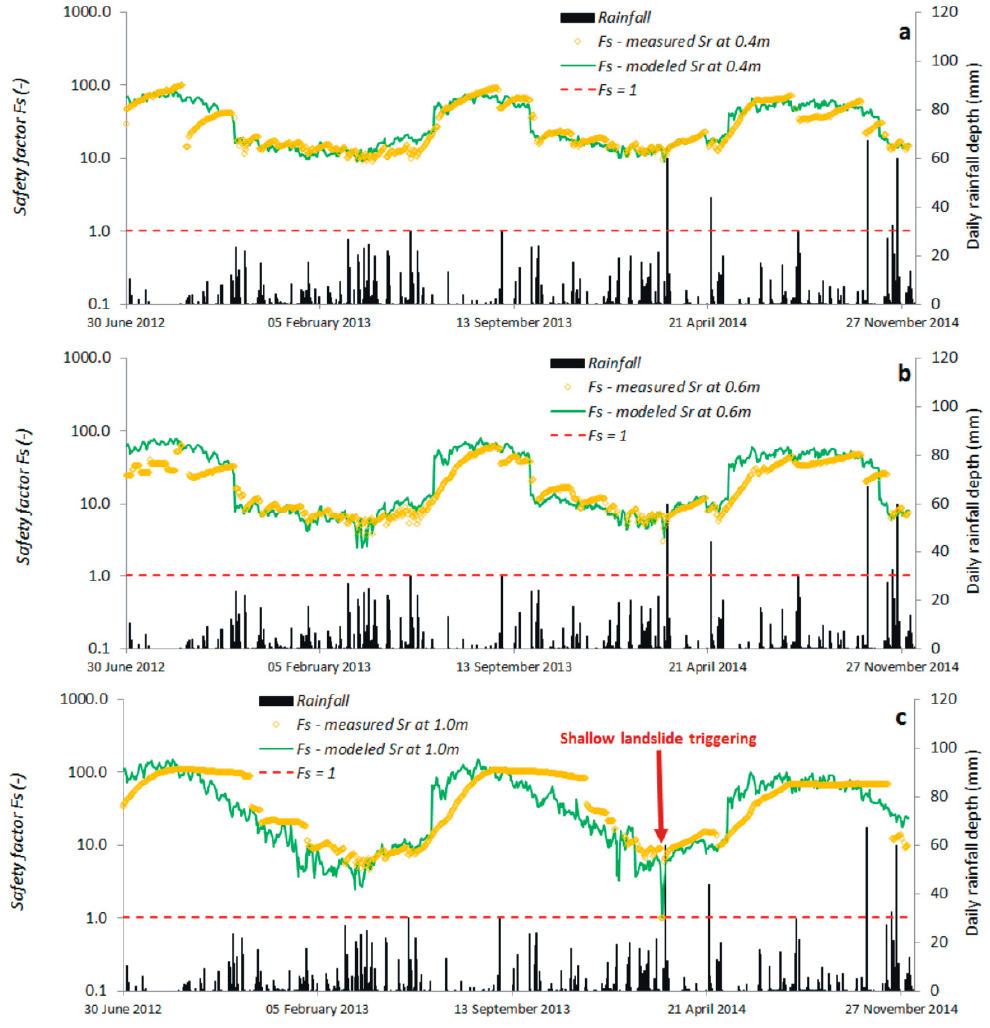
Figure 8. Comparison of the safety factor obtained from the measured and modeled values of the degree of the soil saturation during the monitoring time span at various depths belowthe ground level: ( a ) 0.4 m; ( b ) 0.6 m; and ( c ) 1.0 m.